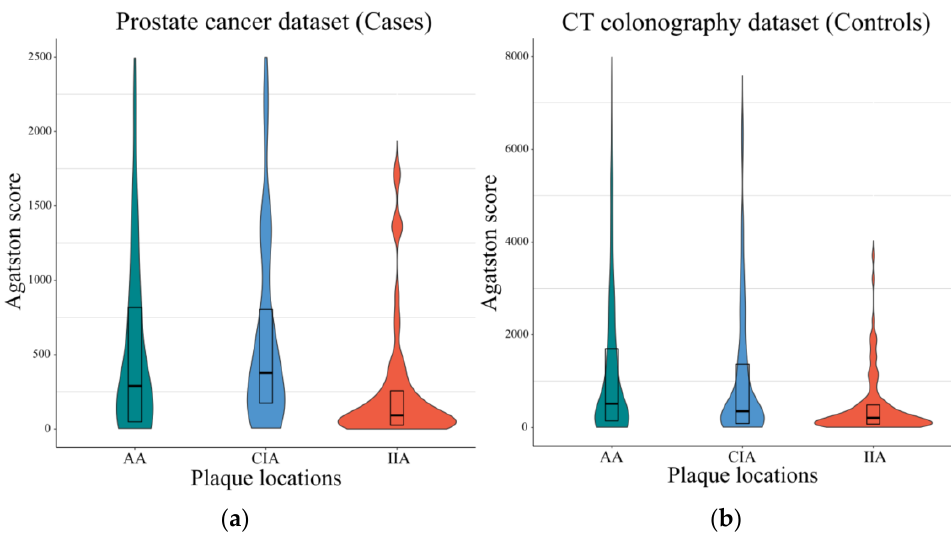
Figure 3. Agatston scores of Cases and Controls patients in different arterial territories. ( a ) Agatston scores of Cases patients in different vessels. The median scores were 340 (IQR, 60-930) for the abdominal aorta (AA), 407 (IQR, 178-1064) for the common iliac arteries (CIA), and 92 (IQR, 28-257) for the internal iliac arteries (IIA). Cases scores are before calibration. Only non-zero plaques are included. The violin plots display the full distribution of the data, and the box plots represent the median, upper, and lower quartiles. ( b ) Agatston scores of Controls patients in different vessels. The median scores were 555 (IQR, 152-2212) for the AA, 349 (IQR, 89-1364) for the CIA, and 208 (IQR, 76-486) for the IIA. Abbreviations : IQR, interquartile range.